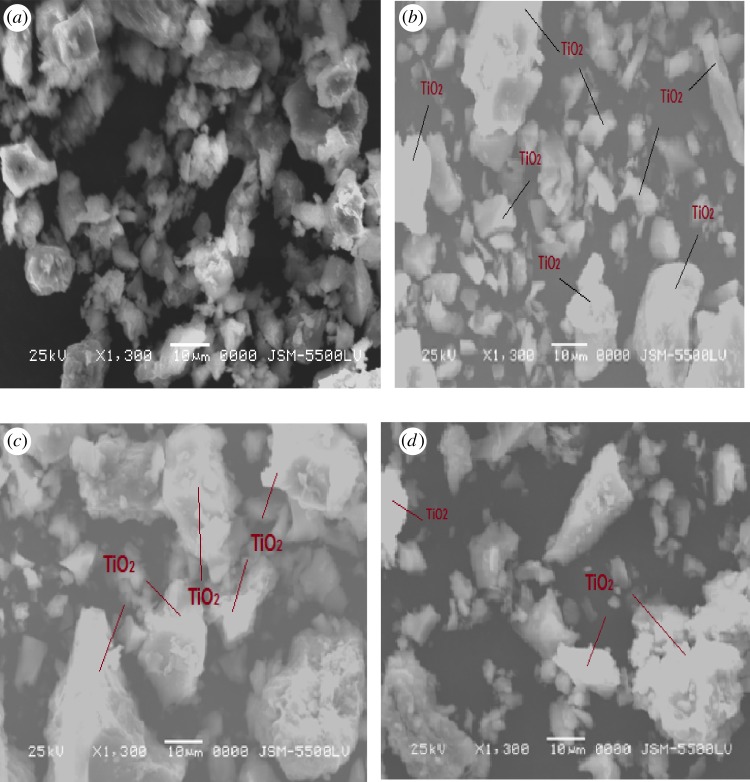
SEM images for ASS, TiO2/ASS (1 : 1), (1 : 2) and (1 : 3). (a) ASS at ×1300 and ×800. (b) TiO2/ASS (1 : 1) at ×1300 and ×850. (c) TiO2/ASS (1 : 2) at ×1300 and ×850 (d) TiO2/ASS (1 : 3) at ×1300 and ×1600.